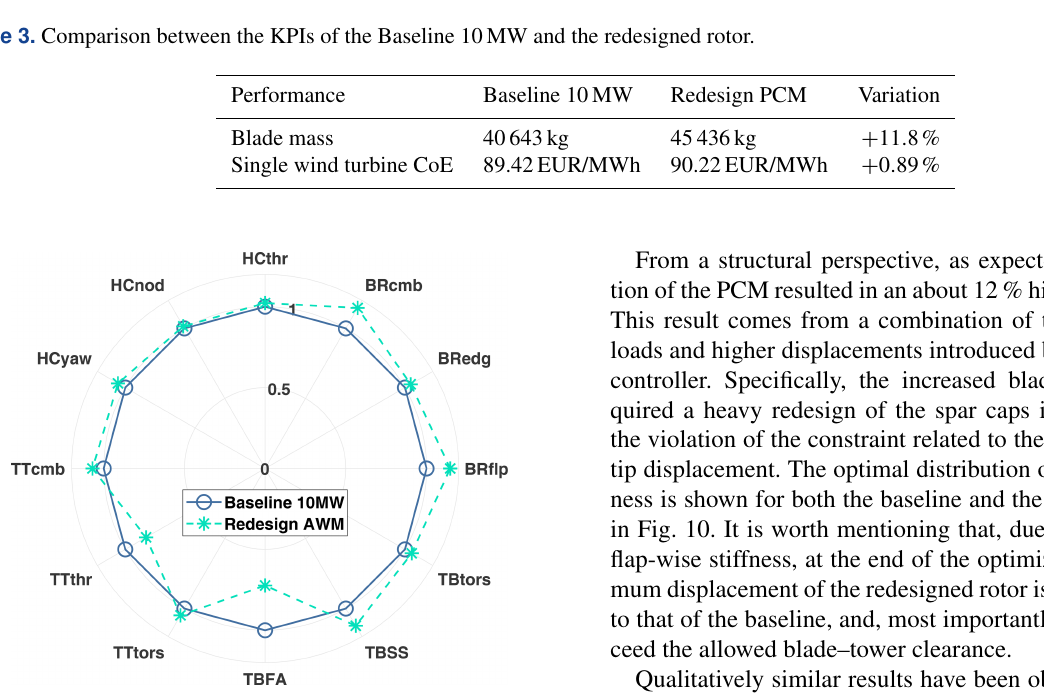
Figure 9. Ultimate loads resulting after the redesign process includ- ing PCM. BR is blade root, HC is hub center, TT is tower top, and TB is tower